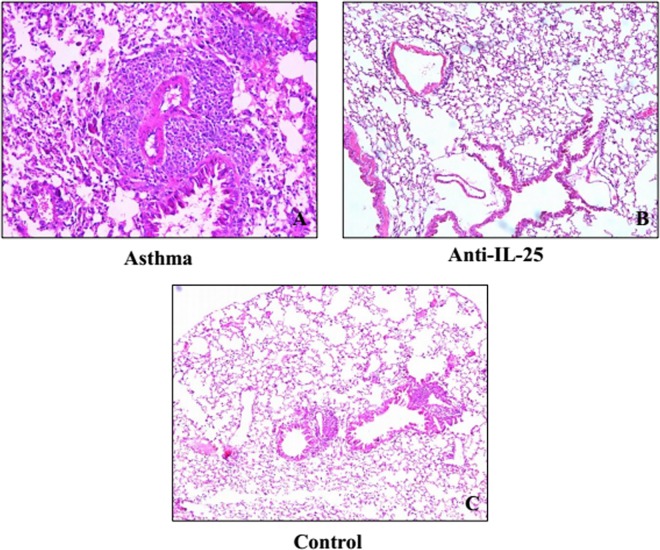
Lung histology.Pathological sections of lung tissues were harvested after 24h, fixed with buffered formalin, and then 5-micrometer sections were analyzed by HE staining. Original magnification, ×40. A. Asthma group. B.Anti-IL-25 group. C. Control group.